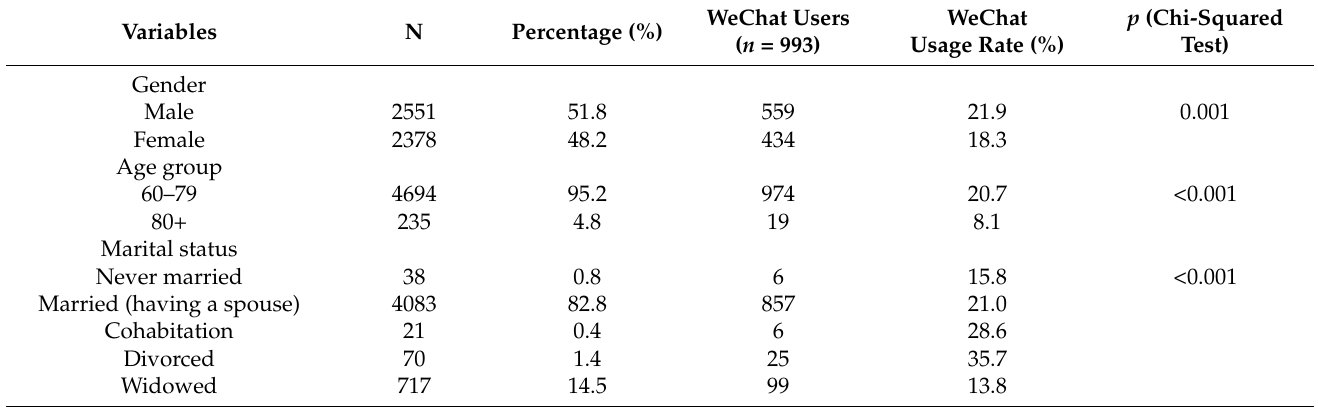
Table 1. Demographic characteristics of and WeChat usage rate in the